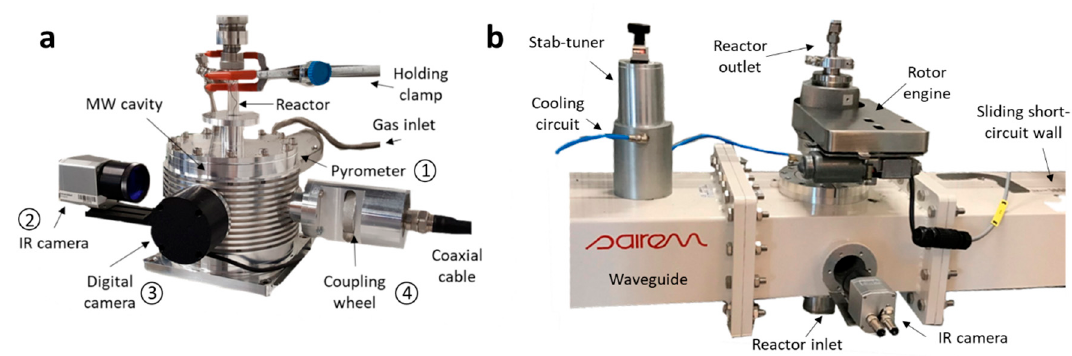
Figure 3. ( a ) Lateral view of the cylindrical TE 111 monomodal cavity employed for lab-scale tests, ( b ) lateral view of the scaled rectangular TE 10x cavity employed for scaling assessment tests.